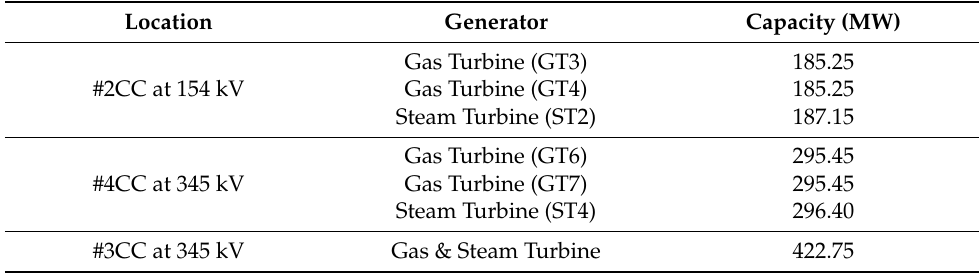
Figure 1. Schematic of the specific power system for analysis of temporary transient overvoltage (TOV) phenomena with respect to MOV surge arrester in line-commutated converter (LCC)-HVDC transmission system. Table 1. Description of turbine generators.